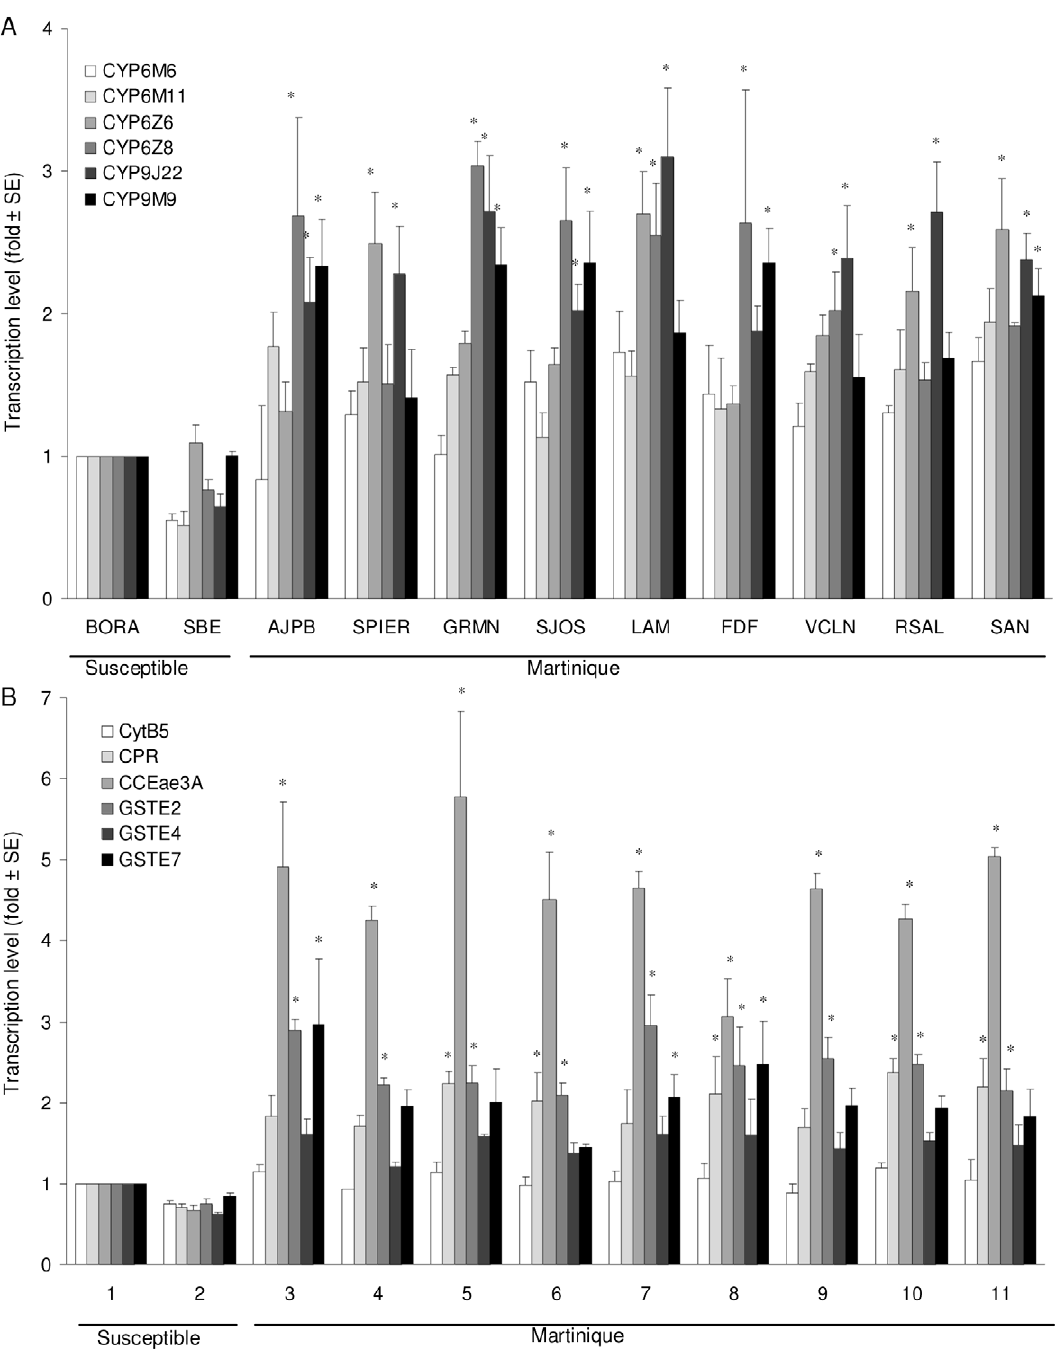
Figure 3. Adult transcription levels of (A) 6 cytochrome-P450-monooxygenases and (B) 2 P450-cofactors, 3 GST and 1 CCE genes estimated in the populations of Martinique and the susceptible SBE strain relative to the susceptible Bora-Bora strain. Transcription ratios obtained from real-time quantitative RT-PCR were normalized with the 2 housekeeping genes AeRPL8 and AeRPS7 and shown as mean value ( 6 SD) over 3 independent biological replicates. Genes significantly over-transcribed (transcription ratio . 2-fold and P value , 0.05) are indicated by stars.